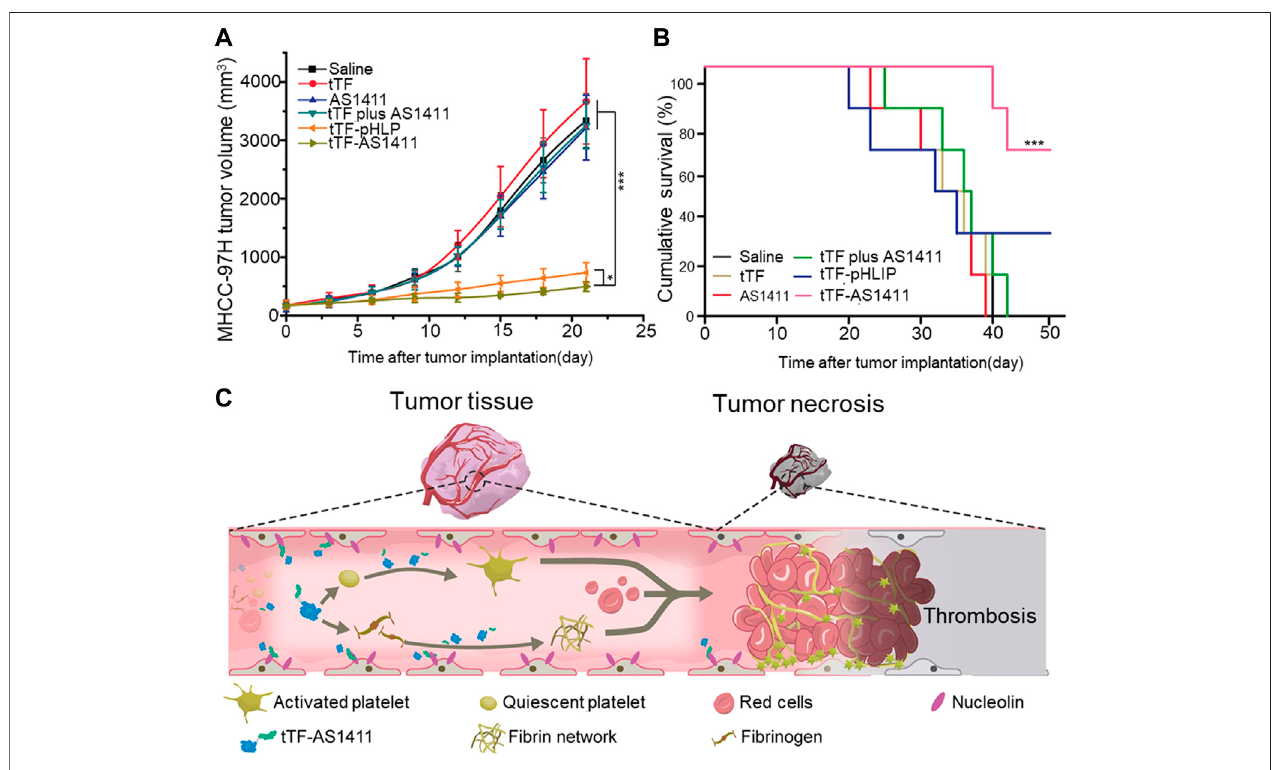
FIGURE 1 | Antitumor activity of tTF-AS1411 (A) The inhibition of the growth of MHCC-97H liver tumors in mice (B) Cumulative survival of MHCC-97H tumor- bearing mice (C) Illustration of the hypothesized progression of tTF-AS1411 within tumor vessels. Reprinted with permission from (Li et al., 2021b).